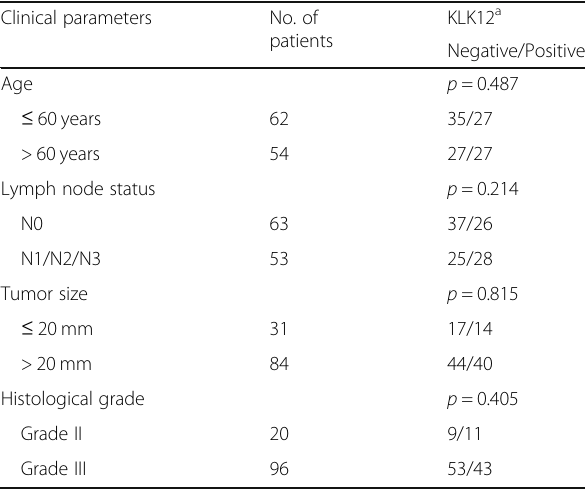
Table 1 Correlation of KLK12 mRNA expression